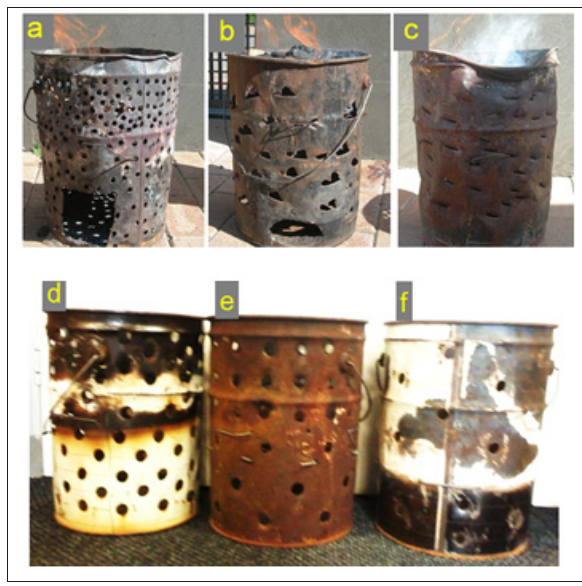
Photographs of experimental field procured braziers with (a) high ventilation, (b) medium ventilation and (c) low ven- tilation; and experimental lab-designed braziers with (d) high ventilation, (e) medium ventilation and (f) low